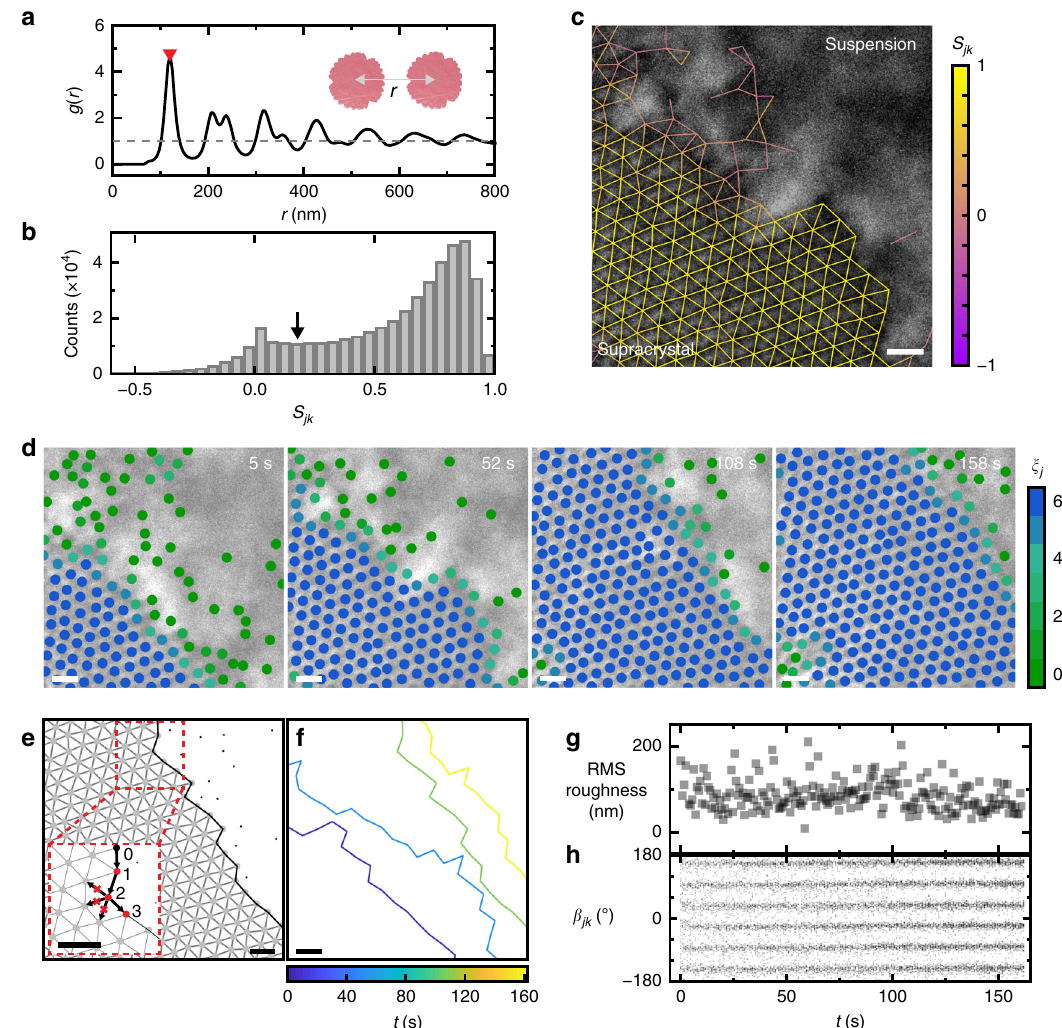
Fig. 2 Pro fi ling of the surface layer in the supracrystal system. a Radial distribution function g ( r ) as a function of r (de fi ned in the inset schematic) for the supracrystal computed from Supplementary Movie 2. The red triangle denotes the r value corresponding to the lattice constant σ . b Histogram of the connectivity S jk computed from Supplementary Movie 2, with S c denoted with the black arrow. c Liquid-phase TEM image of the supracrystal interfaced with the suspension overlaid with the bond connection network color labeled according to S jk values. d Time-lapse TEM images overlaid with tracked column positions ( fi lled circles colored to the values of ξ j for the j th column). e The bond connection diagrams corresponding to one TEM image in d (108 s), where columns that belong to the supracrystal are labeled as gray fi lled circles and others are labeled as black dots. The supracrystal surface, i.e., the outermost surface layer of the supracrystal, is traced as the black line. A zoomed-in view (inset) shows how the columns at the surface are traced one-by- one in sequence. f Surface pro fi les corresponding to the TEM images in d color coded by elapsed time. g Temporal evolution of the root mean square (RMS) roughness of the surface. h Temporal evolution of the bond angles β jk between the j th column and its k th nearest neighbor. Scale bars: 200